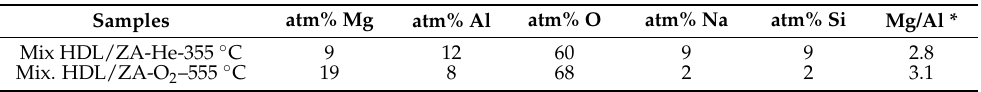
Table 3. Chemical analysis of the LDH and zeolite A physical mixture samples after different treatments and rehydration with H 2 O